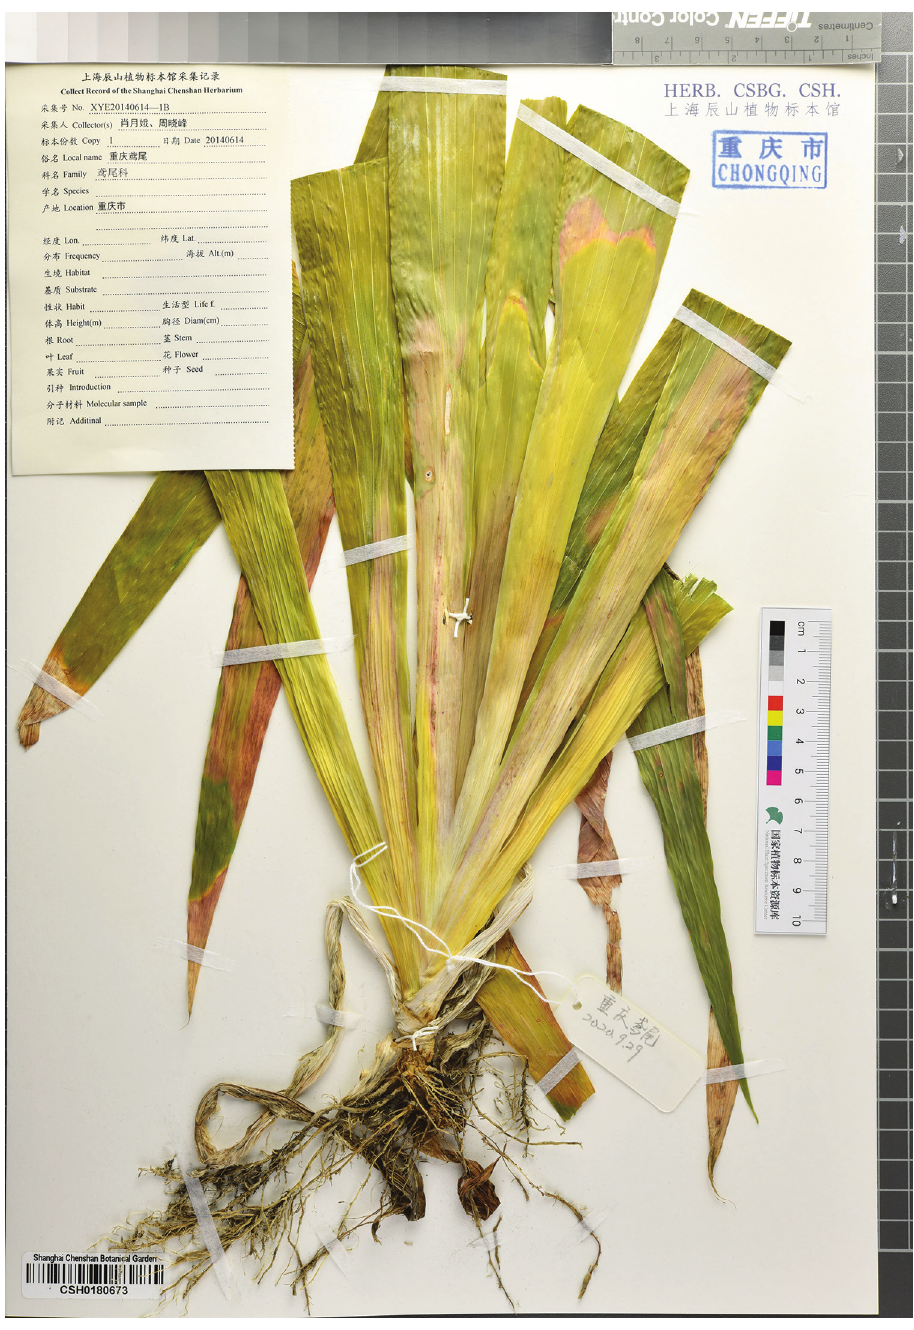
Figure A1. The photo of holotype of Iris × ampliflora